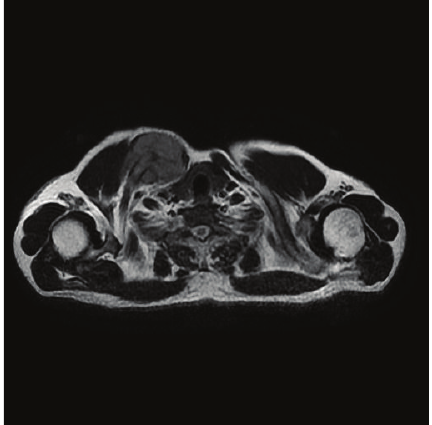
F 1: Axial MRI section with mass on the medial side of the clavicle.